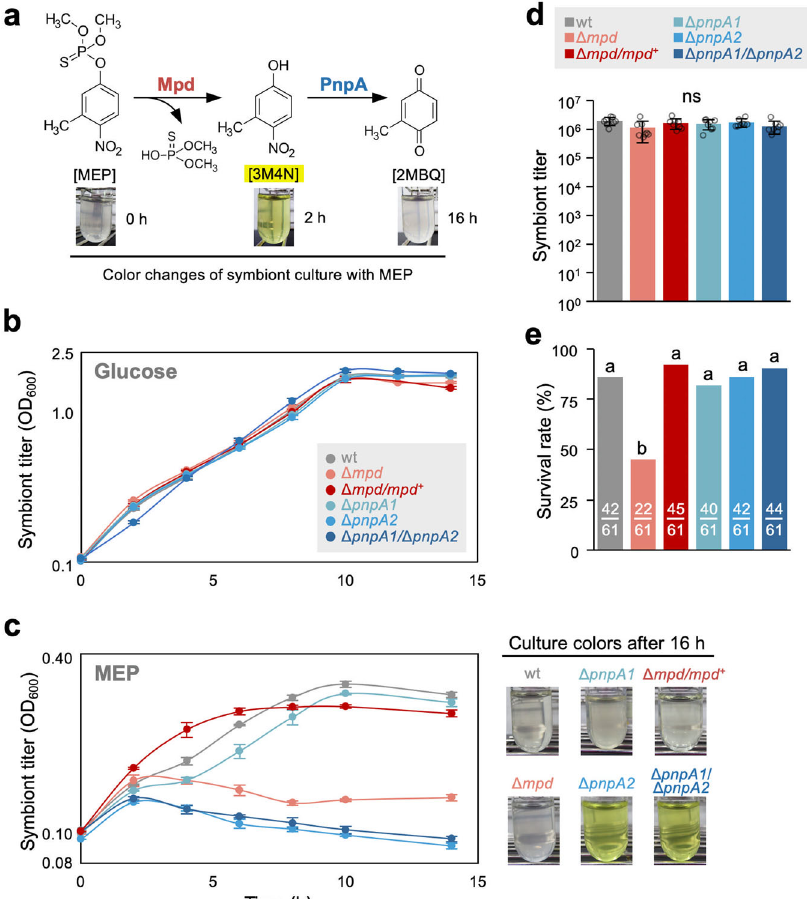
Fig. 2 The fi rst catabolic step of MEP degradation is critical for the symbiont-mediated insecticide resistance. a Partial MEP-degradation pathway and corresponding color changes in wild-type SFA1 culture with MEP. b , c Growth rates of wild-type SFA1, mpd ( Δ mpd ) and pnpA gene-deletion mutants ( Δ pnpA1 , Δ pnpA2 , and Δ pnpA1/ Δ pnpA2 ), and mpd -complement mutant ( Δ mpd / mpd + ) in ( b ) glucose and ( c ) MEP medium. Mean± SD of three replicates are indicated. Photos of culture media (16 h after inoculation) are shown on the right side of ( c ). The medium of Δ pnpA2 and Δ pnpA1 / Δ pnpA2 became yellow because of 3M4N accumulation. d Colonization titers of the wild-type and mutant strains in midgut crypts. Symbiont titer between the groups was calculated by qPCR of the dnaA gene of the symbiont. Mean ± SD of eight replicates are indicated. ns indicates statistical insigni fi cance (two-sided Mann – Whitney U test after Bonferroni correction). e Survival rates after MEP treatment in insects infected with either wild type or mutants. Number of replicates are depicted on the bars. Different letters indicate statistically signi fi cant differences ( P < 0.05, two-sided Fisher ’ s exact test after Bonferroni